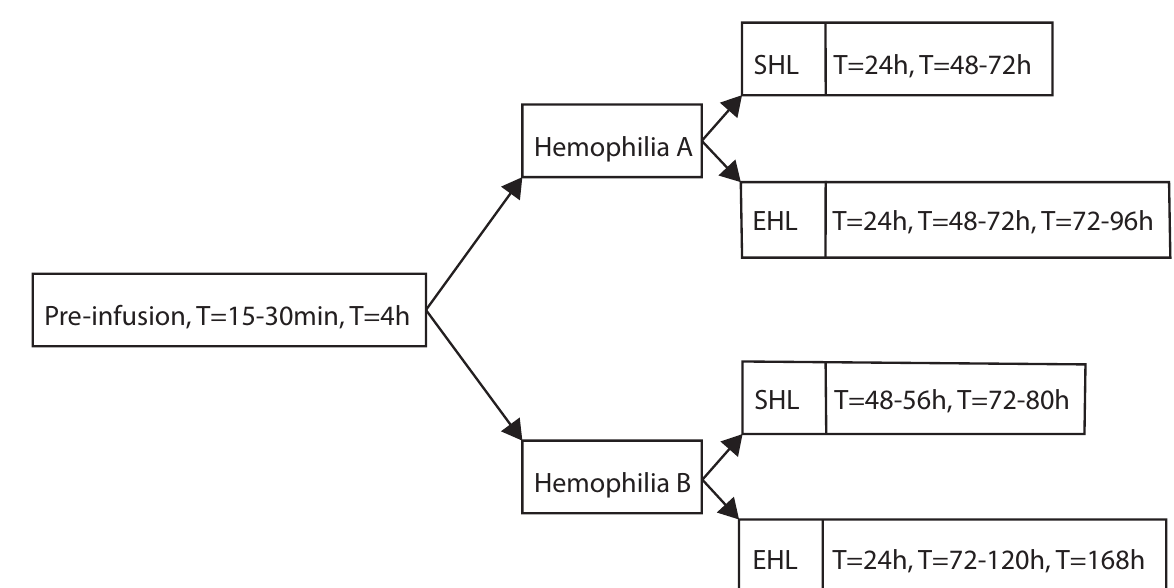
Fig. 2 Time points (T) of laboratory tests during individual PK-pro fi ling. A preinfusion, t ¼ 15 – 30minutes and t ¼ 4hours sample (left) are performed in all patients. The other time points (right) depend on hemophilia type and brand of factor concentrate. EHL, extended half-life; PK, pharmacokinetic; SHL, standard